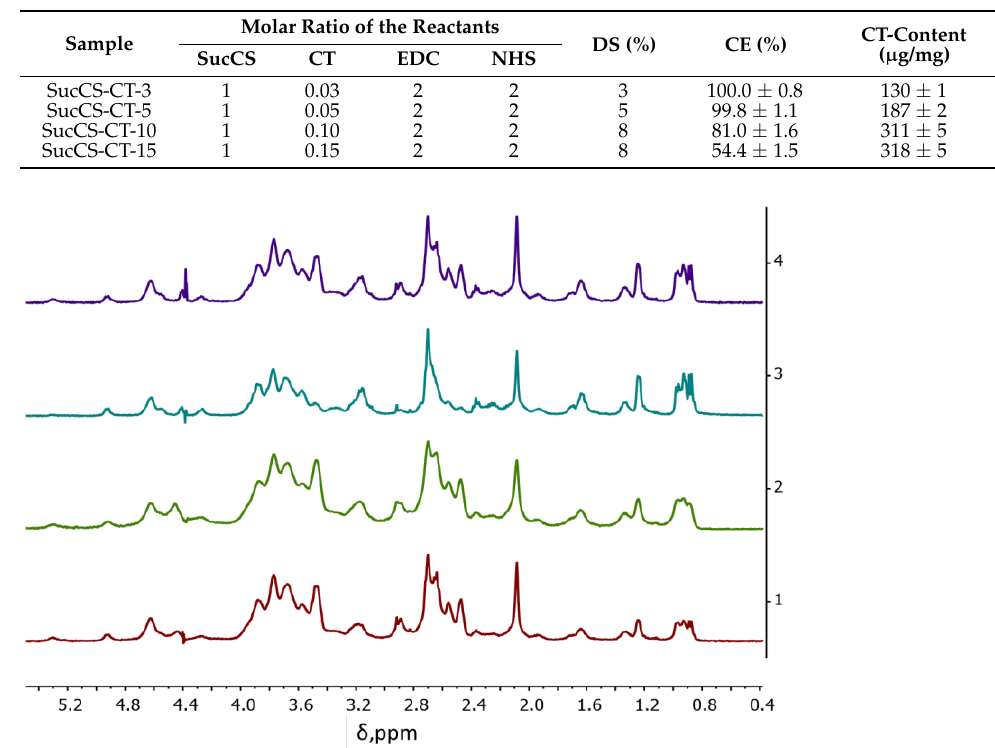
Figure 2. Stacked 1H NMR spectra of succinyl chitosan-colistin conjugates (SucCS-CT) samples: 1-SucCS-CT-3; 2-SucCS-CT-5; 3-SucCS-CT-10; 4-SucCS-CT-15.